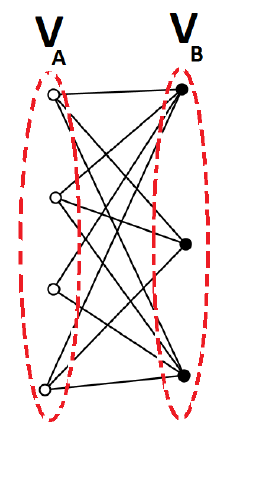
Figure 5: A bigraph. There are two sets of disjoint vertices (white and black colored). No edges among white nodes as well as black